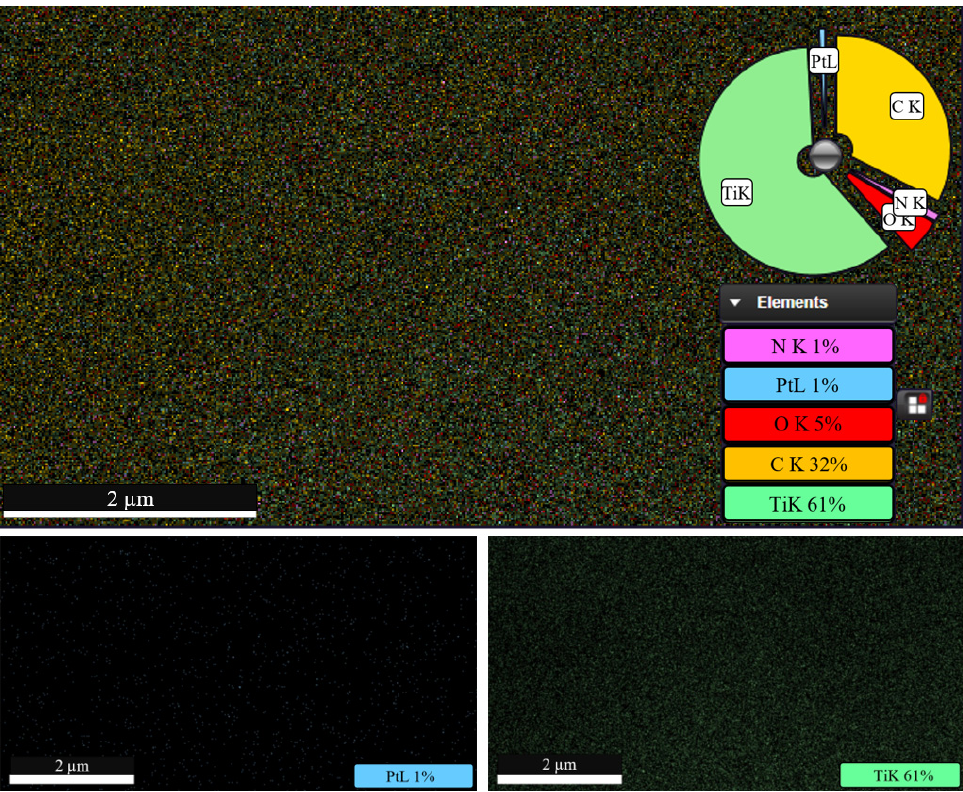
Figure 11. Distribution of TiO 2 and PtOEP particles in the coating material.